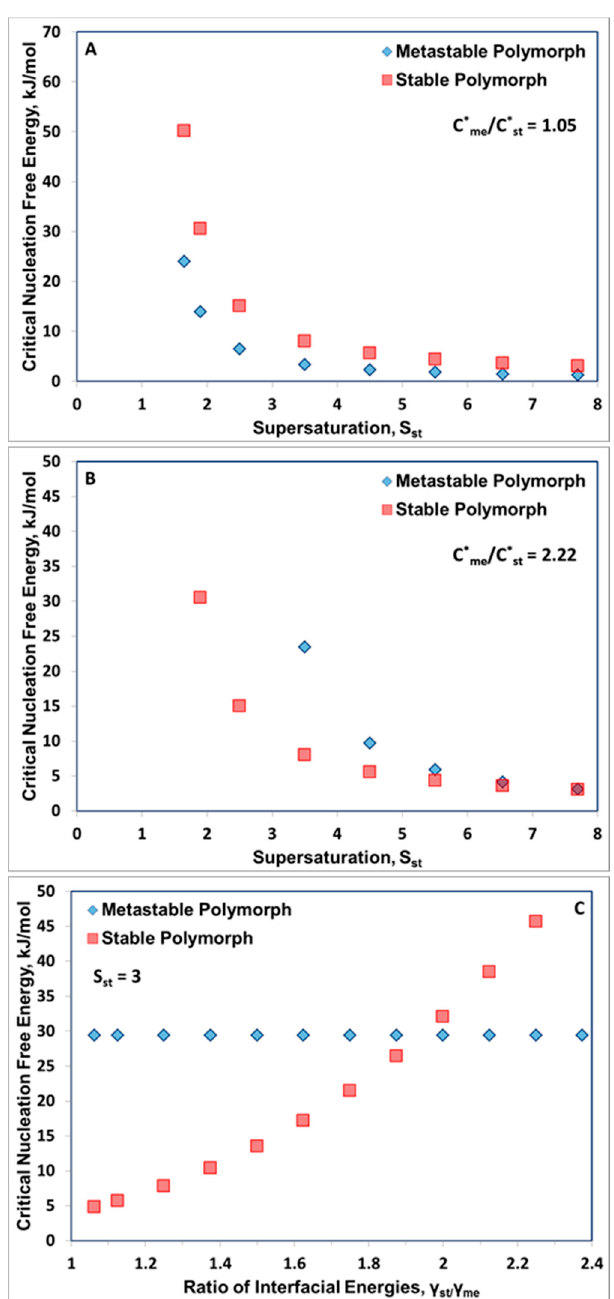
Figure 1. ( A , B ): Influence of Supersaturation with respect to the Stable Polymorph ( S st ) on the Critical Nucleation Free Energies ( ∆ G* c ) for C* me / C* st = 1.05 ( A ), C* me / C* st = 2.22 ( B ), Temperature 293 K; γ me = 4 mJ m − 2 ; γ st = 5.5 mJ m − 2 ; γ st / γ me = 1.375; V m = 3.5 × 10 − 28 m 3 molec − 1 , ( C ) Influence of Interfacial Energy Ratio ( γ st / γ me ) on the Critical Nucleation Free Energies ( ∆ G* c ) for the Stable and Metastable Polymorphs. γ me = 4 mJ / m 2 ; C* me / C* st = 2.0; Temperature 293 K; S st = 3.0; V m =3.5 × 10 − 28 m 3 molec − 1 [3].